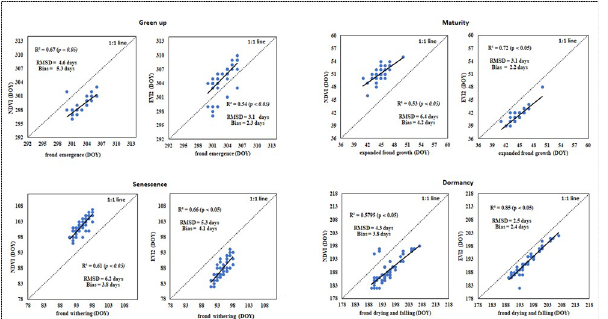
Fig 5. Statistical comparison between satellite-derived bracken fern phenological dates and ground observed phenology.